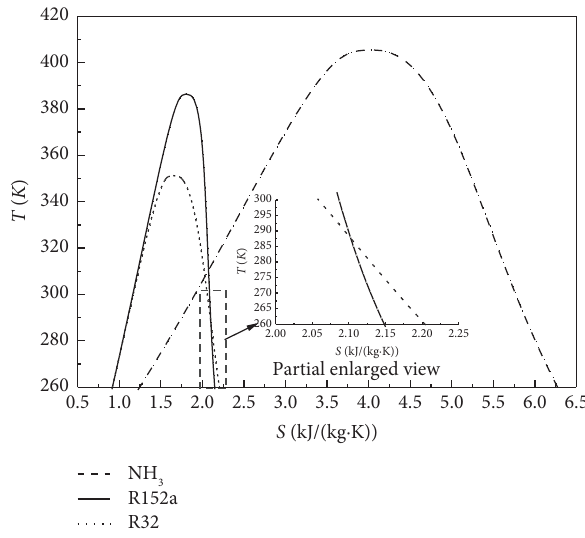
Figure 5: Temperature glide and superheated